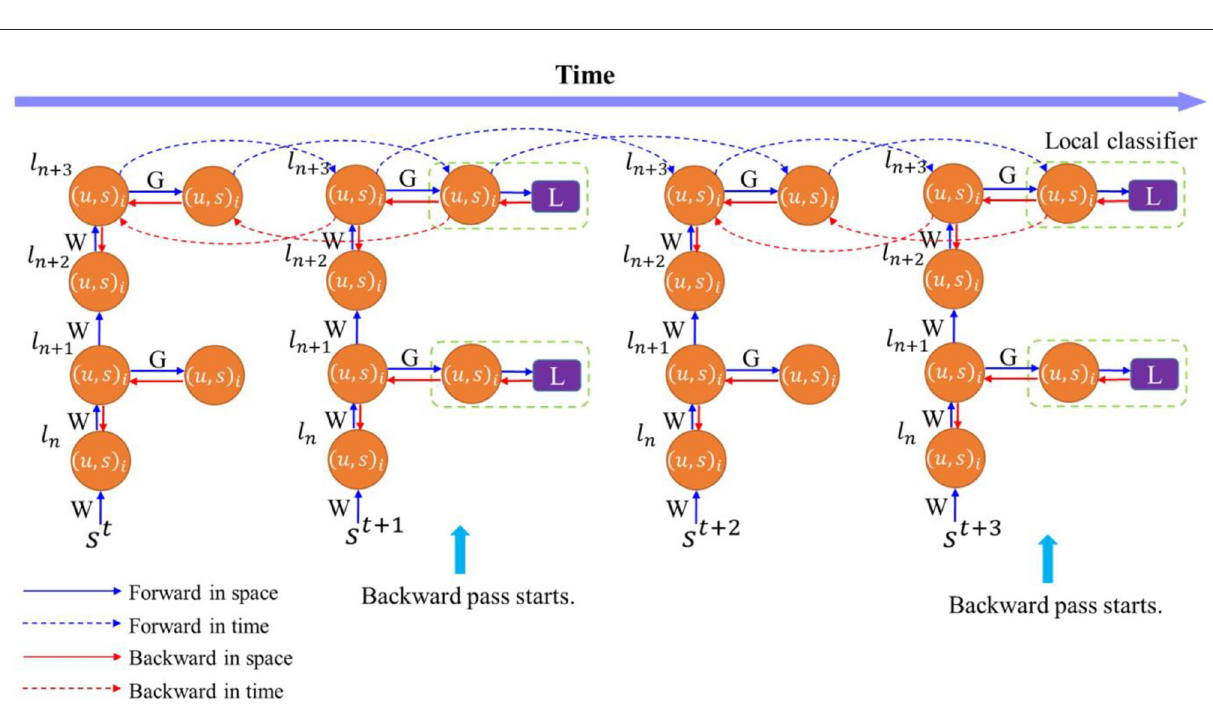
However, LBP suffers from inferior performance compared to the standard BP because of information loss (Wang et al., 2021). Few works have considered LBP in SNNs. Kaiser et al.